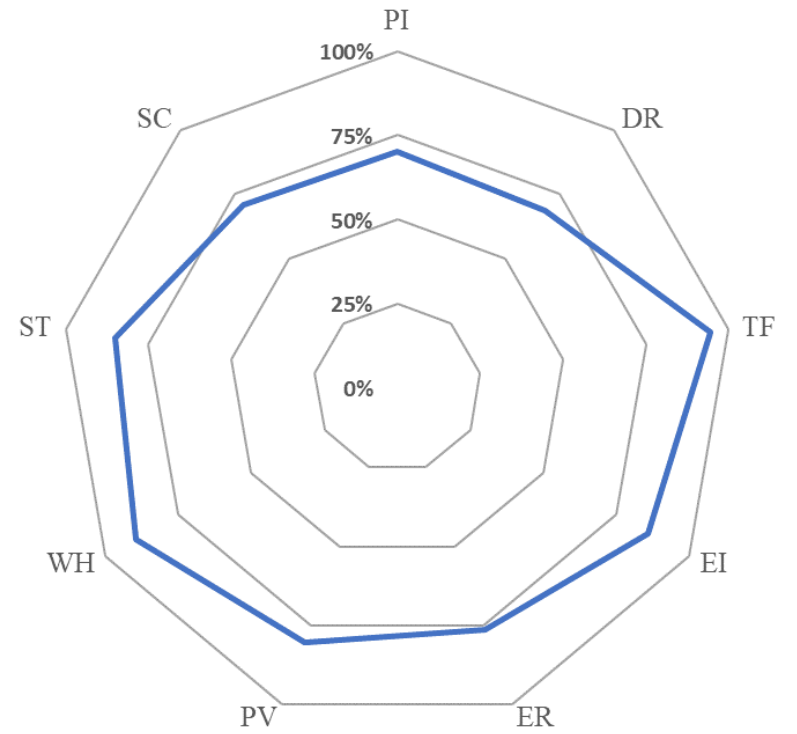
Figure 1. Average positive response rate (APRR) for the nine domains in APSQ.